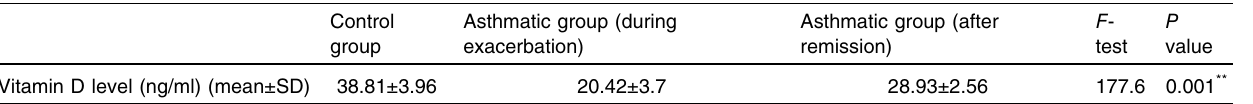
Table 2 Comparison between vitamin D level between the control group, the asthmatic group during exacerbation, and the asthmatic group after